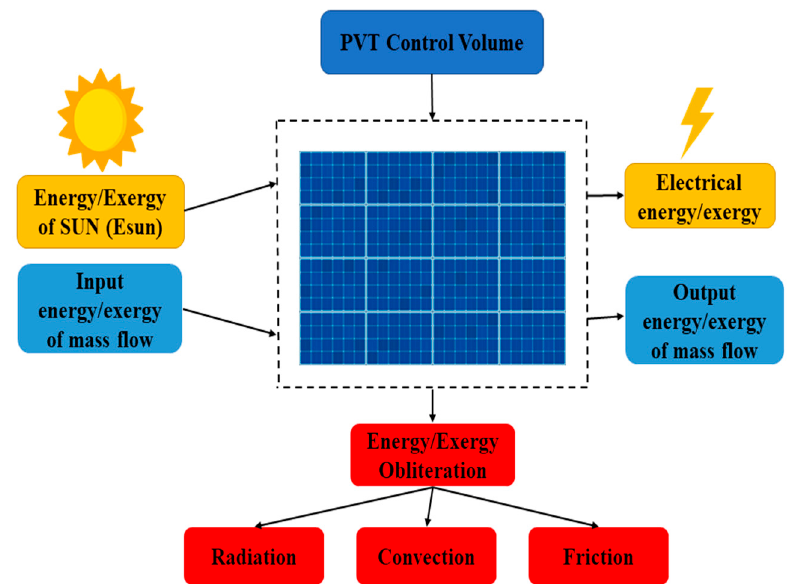
Figure 2. Schematic diagram of energy and exergy flow in PV/T panel control volume.